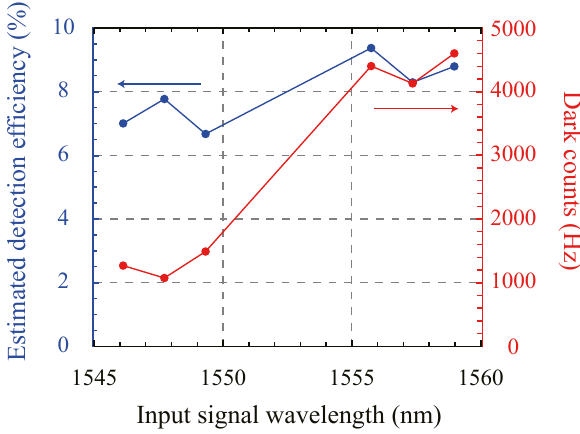
Figure 7: Detection efficiency and dark counts measurement results with the six wavelengths of the telecom photon.